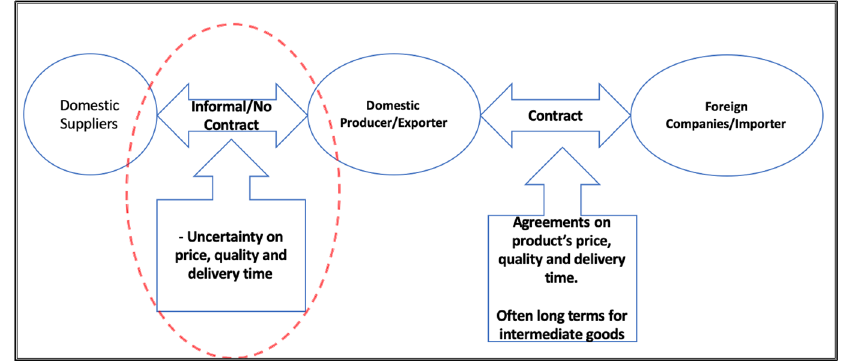
Fig. 6 Domestic supplier–exporter–importer relationship. Source: authors’